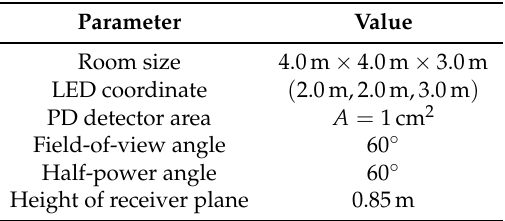
Table 1. Key system